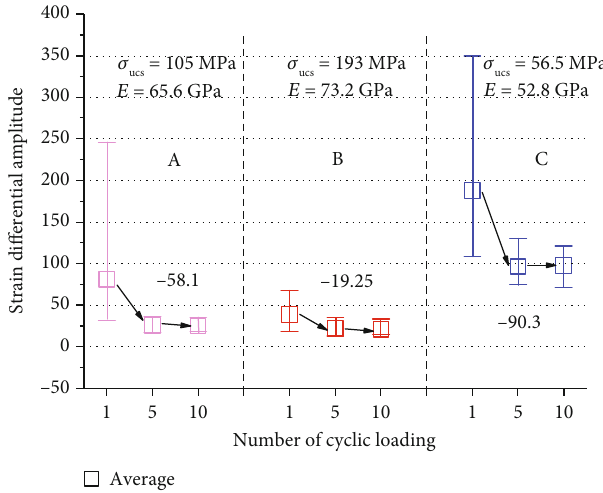
Figure 10: Variation of strain di ff erence amplitude under di ff erent cyclic load times.